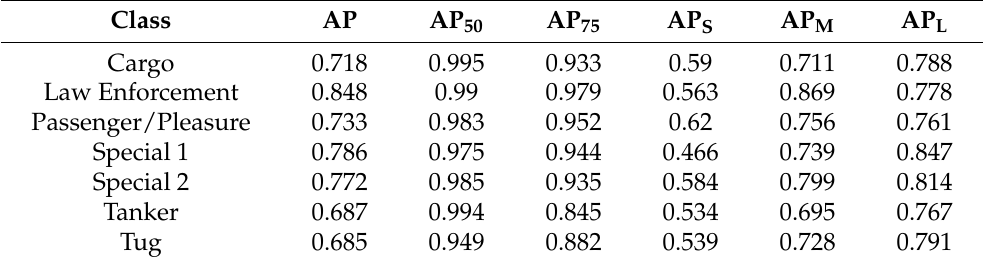
Table A2. Resulting instance segmentation APs per class of the ShipSG dataset using DetectoRS, as explained in Section